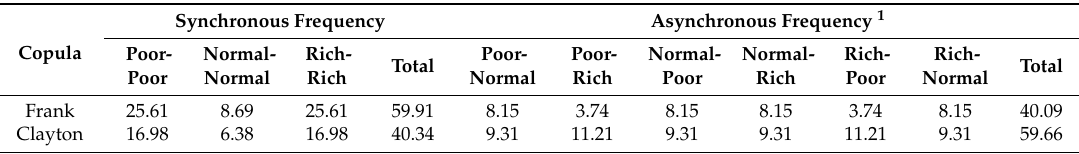
Table 8. The frequency analysis of synchronous-asynchronous encounter of rich-poor annual runoff of tributaries in case of Frank and Clayton copulas